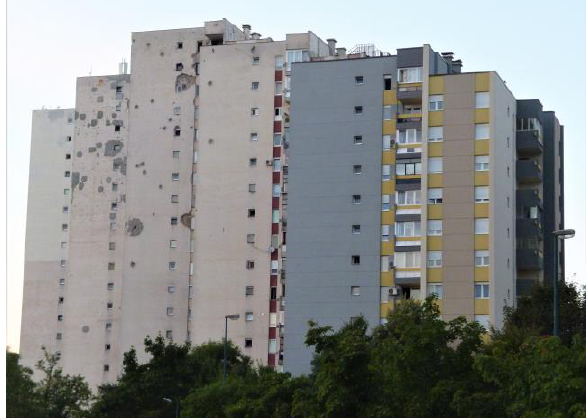
Figure 2 . One of the buildings in the municipality Novi Grad that was refurbished according to standards of energy efficiency (left part of the building damaged during the war, right part